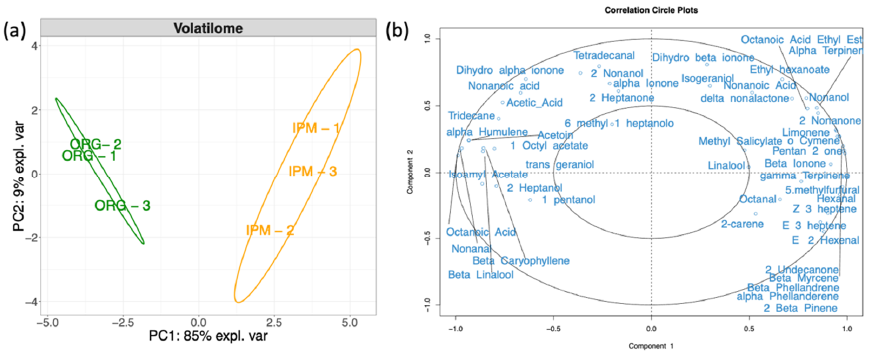
Figure 6. ( a ) Principal Component analysis of volatile organic compounds (VOCs) of raspberry fruits ‘Enrosadira’ cultivated with organic or IPM practices. Ellipses enclose confidence level = 95%. ( b ) Correlation circle plot with discriminating VOCs is shown.